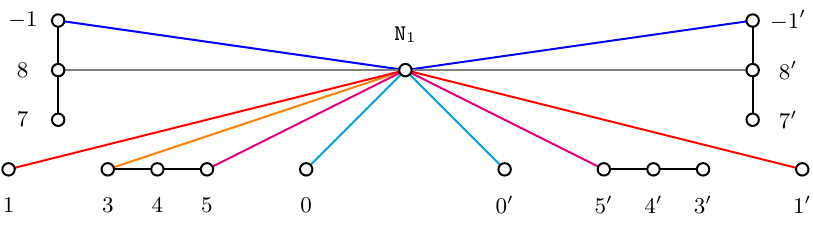
Figure 13. Dynkin diagram showing in di(cid:11)erent colors some (arbitrary) possible connections for the new node N 1